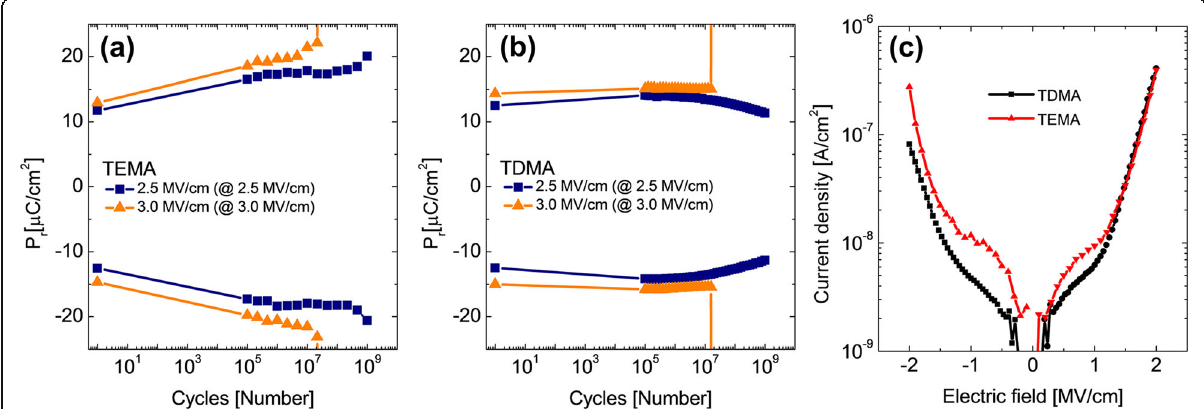
Fig. 5 The results of endurance test of ( a ) TEMA HZO (reproduced from Ref. 39) and ( b ) TDMA HZO with the electric field cycling and pulse field amplitude of 2.5 and 3.0 MV/cm. The frequency of the rectangular double pulse for the endurance test was fixed at 100 kHz. ( c) The current density – electric field curves of TDMA HZO (black) and TEMA HZO (red; reproduced from Ref.